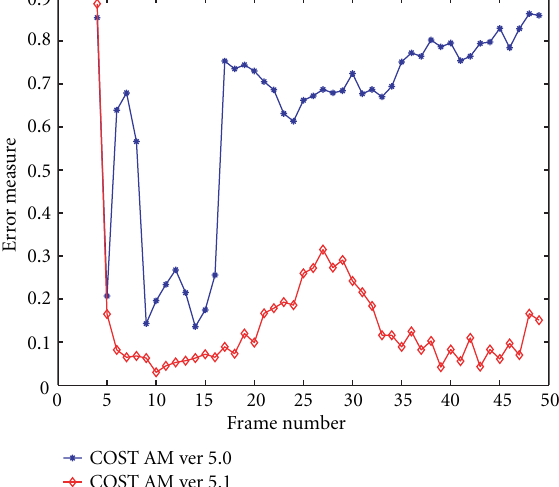
• number of pixels of the background segmented as fore- ground